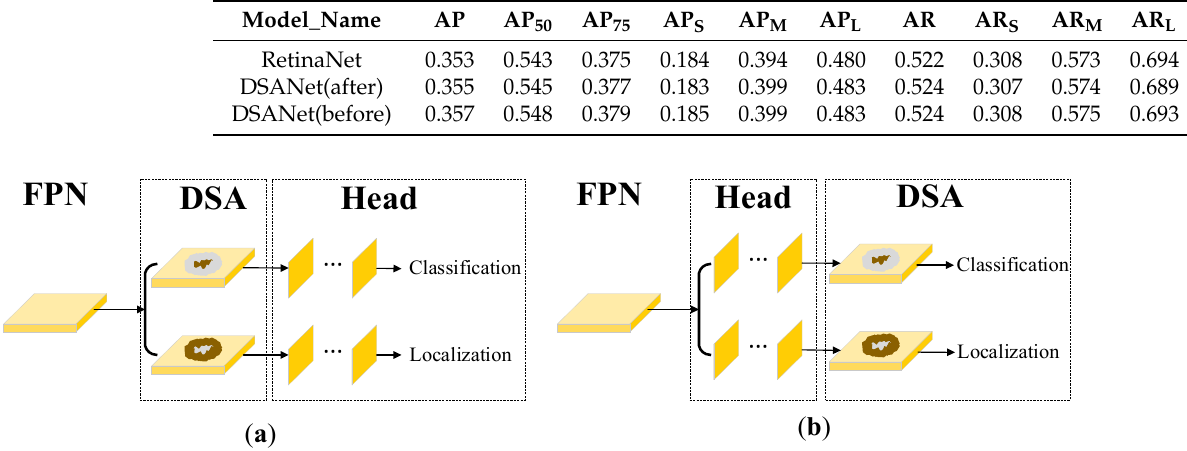
Figure 5. Different location of DSA module in RetinaNet. ( a ) locates DSA modules between FPN and Head network, while ( b ) locates DSA modules after Head network.